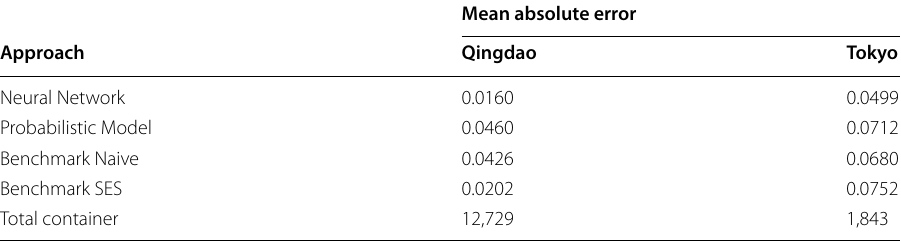
Table 4 MAE of the prediction models for the port of Qingdao and Tokyo. Source :